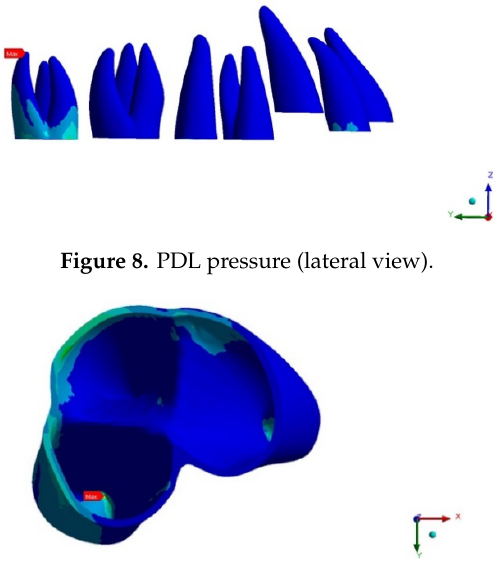
Figure 9. Upper second molar PDL pressure (occlusal view).